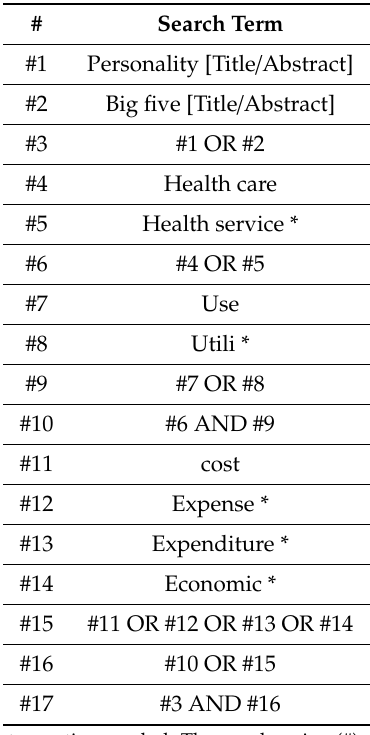
Table 1. Search query